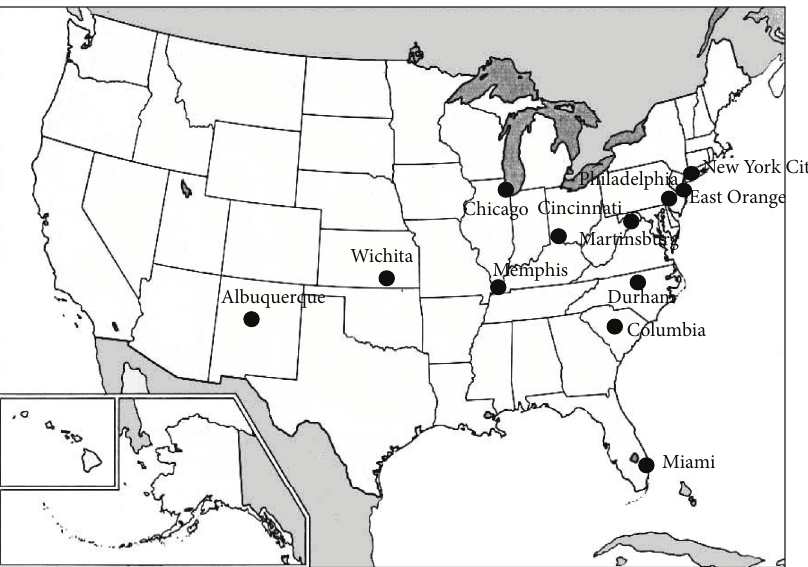
Figure 1: Map of U.S.A highlighting the cities that report the highest frequencies of surgical patients using cocaine.